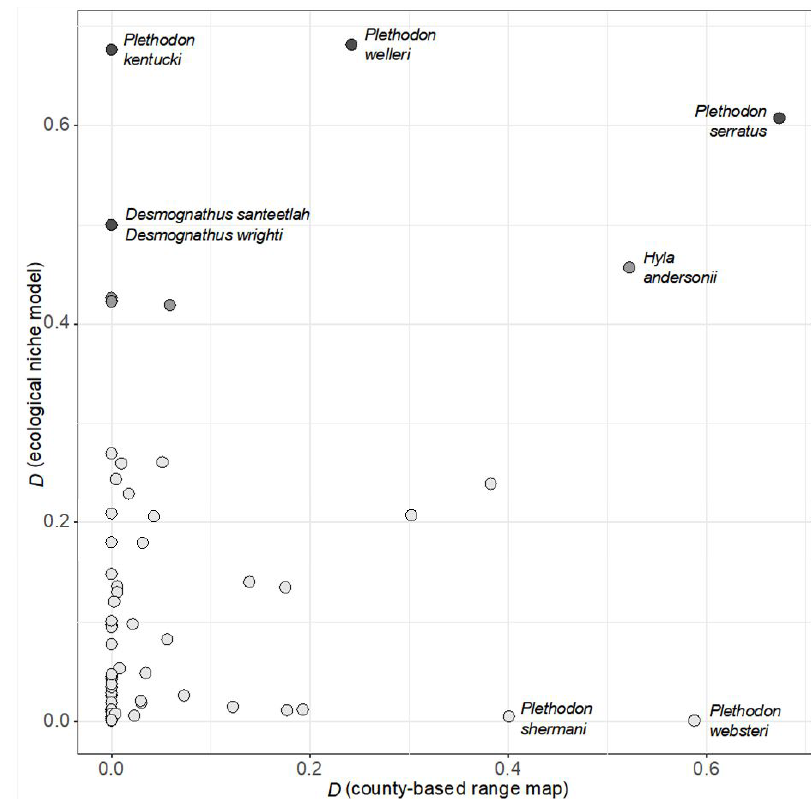
Figure 4. Scatterplot of D values for county-based ranges versus ENMs. Color of points indicates fragmentation category of ENM: dark gray, high fragmentation; medium gray, moderate fragmentation; light gray, low